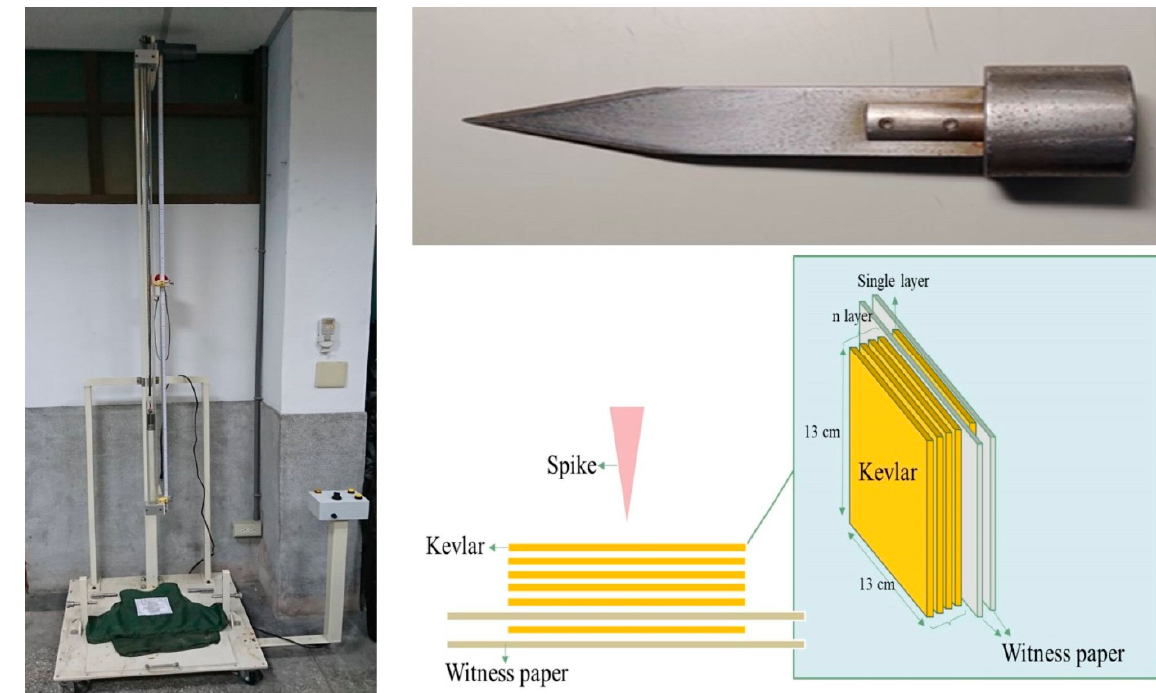
Figure 3. Schematic diagram of the stab test setup.